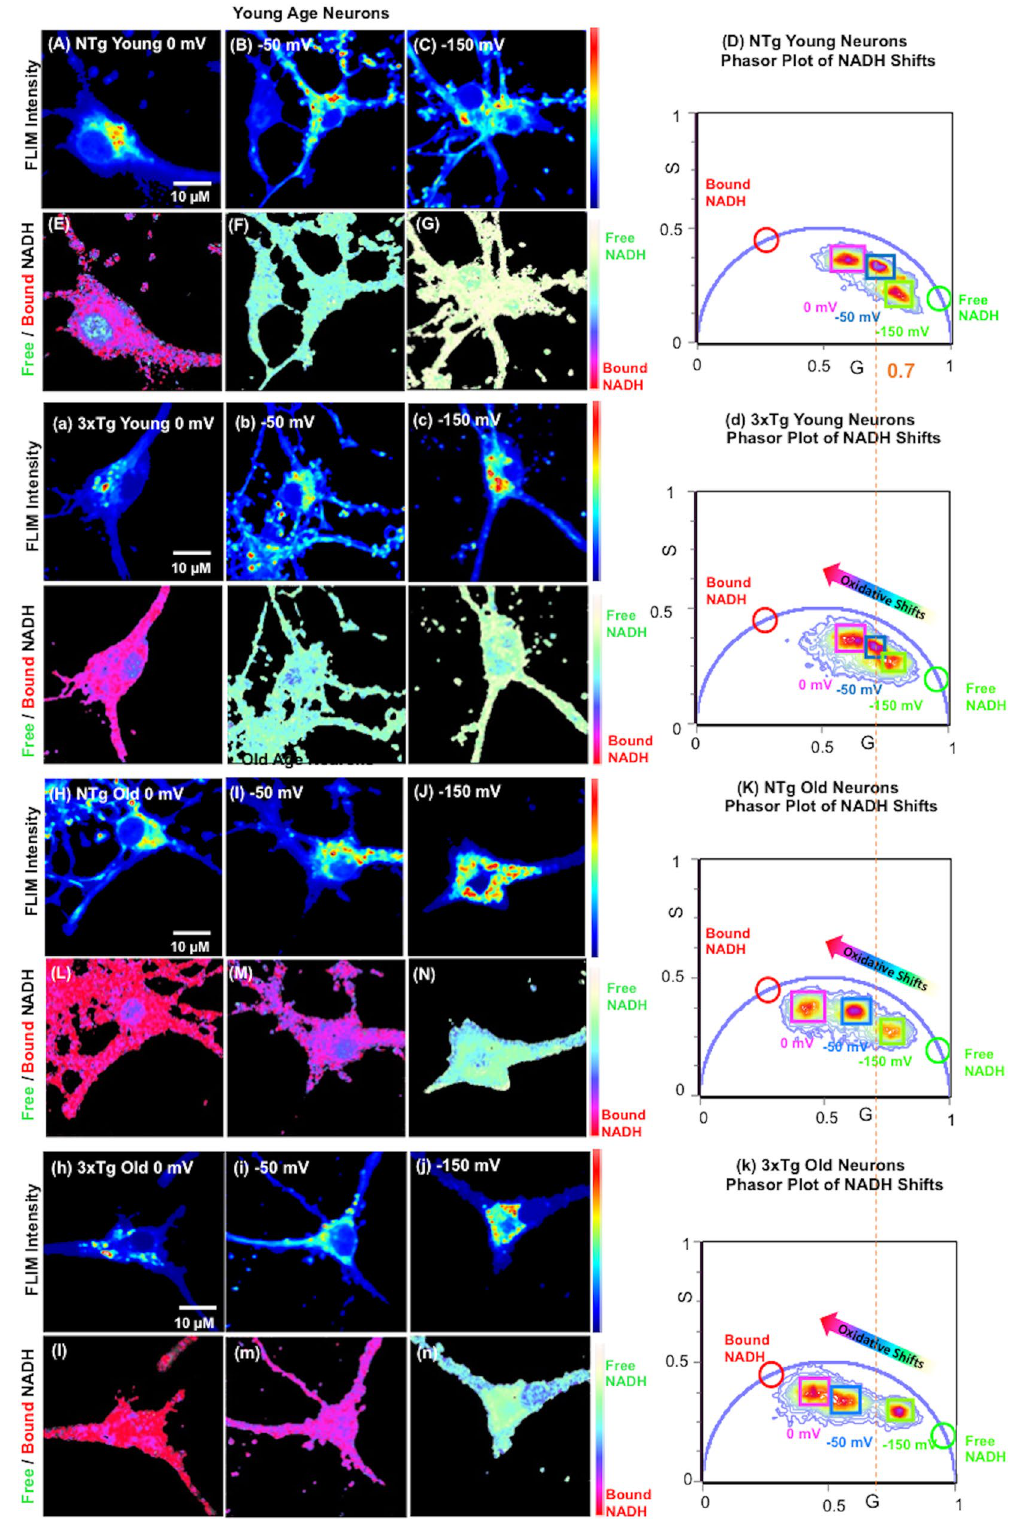
Figure 1. Imposed external Cys/CySS oxidative and reductive states shift the internal NADH redox state in neurons from NTg and 3xTg-AD female mice. FLIM NADH Intensities were collected from NTg ( A – C ) and 3xTg-AD (a–c) in young age neurons under 0 mV (oxidative), − 50 mV (normal medium as control, no treatment) and − 150 mV Cys/CySS (reductive) redox states. ( D ) Phasor plot of the same NTg and (d) 3xTg-AD young age neurons illustrate the shifts of the intracellular free/bound NADH ratios toward more free NADH at reductive − 150mV and to more bound NADH with imposed external oxidative state of 0 mV. Each cluster represents NADH signals from pixels of the corresponding single neuron on the left. The (2019) 9:11274 | https://doi.org/10.1038/s41598-019-47582-x